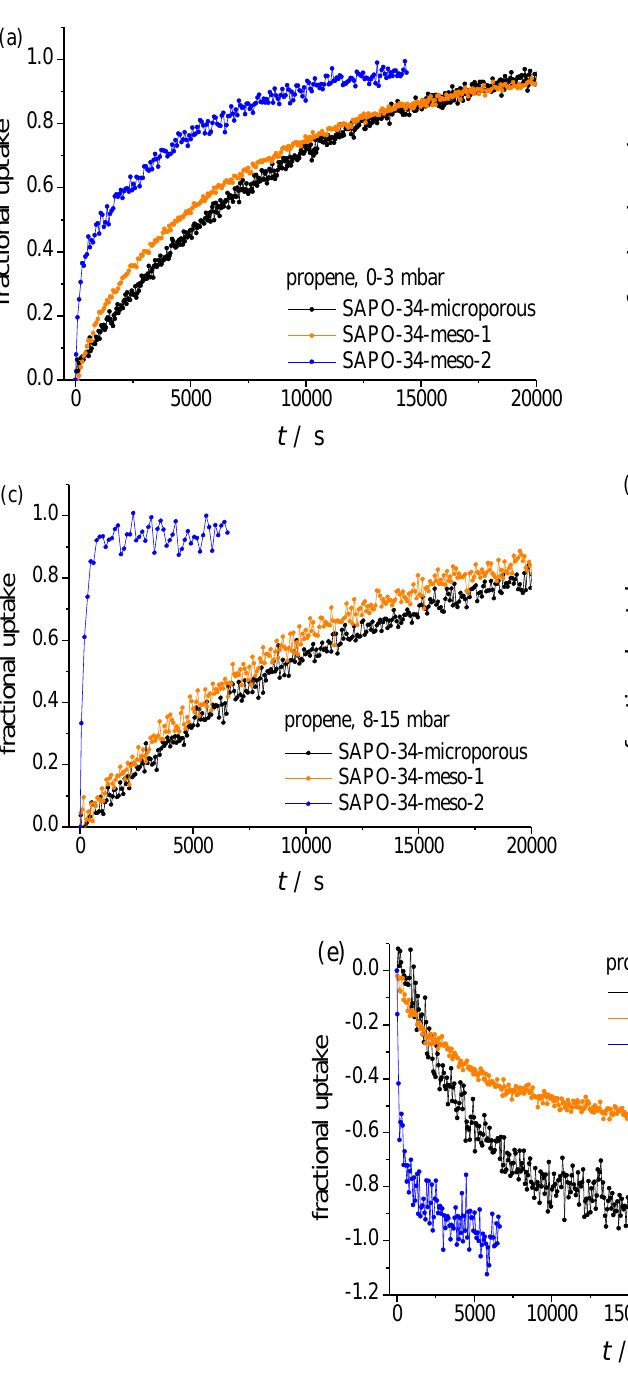
Figure 3. Transient sorption curves of propene at 298 K in the three different specimens of SAPO-34 considering molecular uptake initiated by pressure steps from ( a ) 0–3 mbar; ( b ) 3–8 mbar; ( c ) 8–15 mbar; ( d ) 15–30 mbar; and ( e ) release by a pressure step from 30 to 0 mbar. The particles were selected to have essentially coinciding effective radii, namely about 15 μm for SAPO-34-microporous and -meso-1 and about 17 μm for